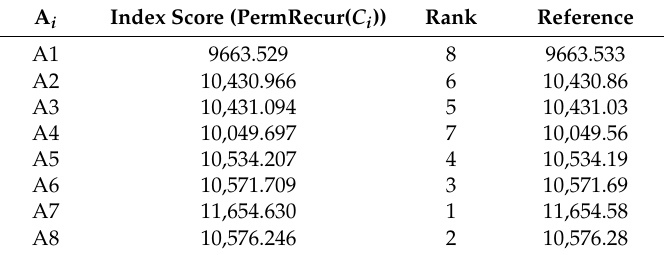
Table 3. The index scores and rank orders assessed by GTMA for the alternatives.